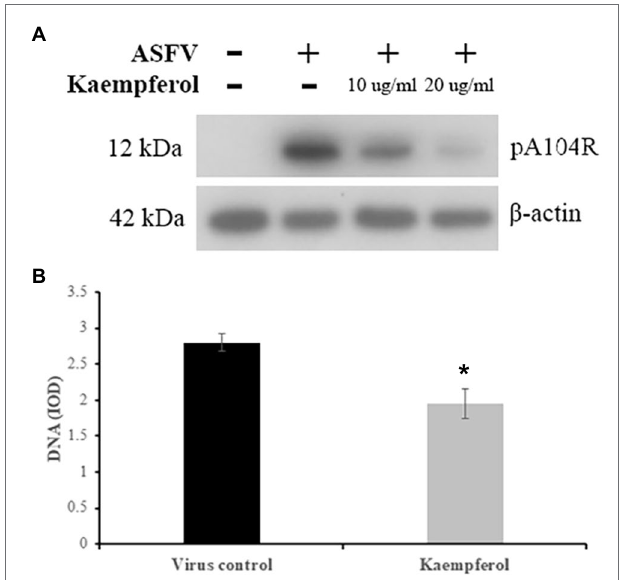
FIGURE 4 | Inhibition of ASFV protein and DNA synthesis in Vero cells. (A) Western blot analysis of ASFV late protein in ASFV-infected cells exposed to kaempferol at different concentrations. β -actin was used as a loading control. (B) DNA content of ASFV factories in cells treated with kaempferol. Results represent the mean (± SD) of three independent experiments ( n = 3). Significant differences compared to control are denoted by * p <